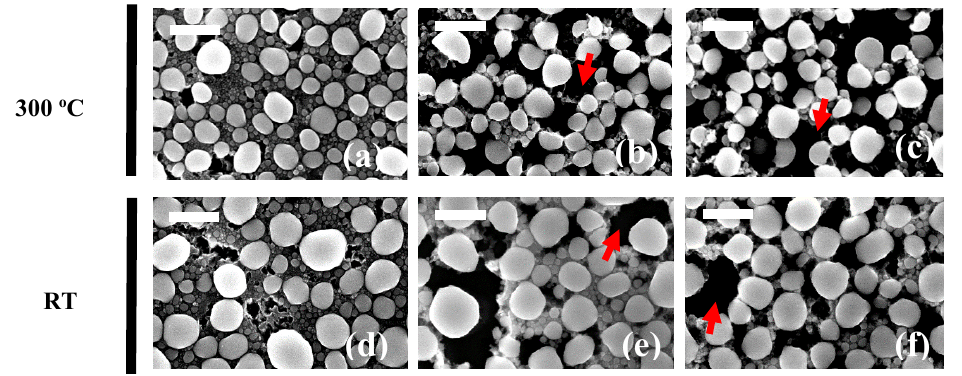
Figure 5. Ga NP/AZO/Si sample immersed in water/phosphoric acid/acetic acid bath for ( a , d ) 5 s ( b , e ) 15 s and ( c , f ) 20 s. Scale bar is 500 nm in length in all the pictures.